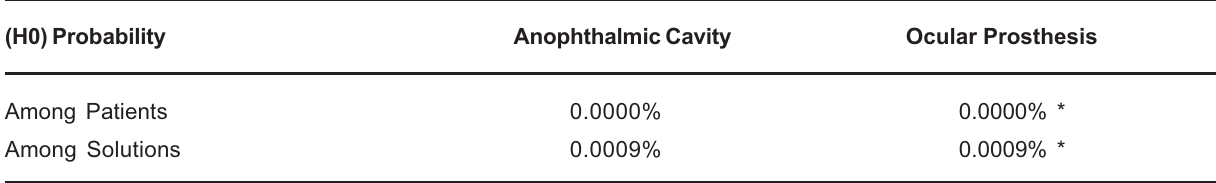
TABLE 3- Results of the analysis of variance for the presence of aerobic microorganisms